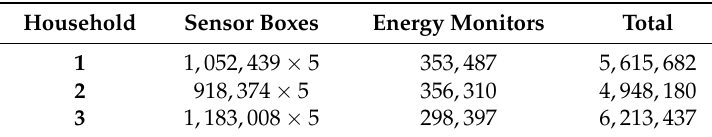
Table 3. Sensor Data Set